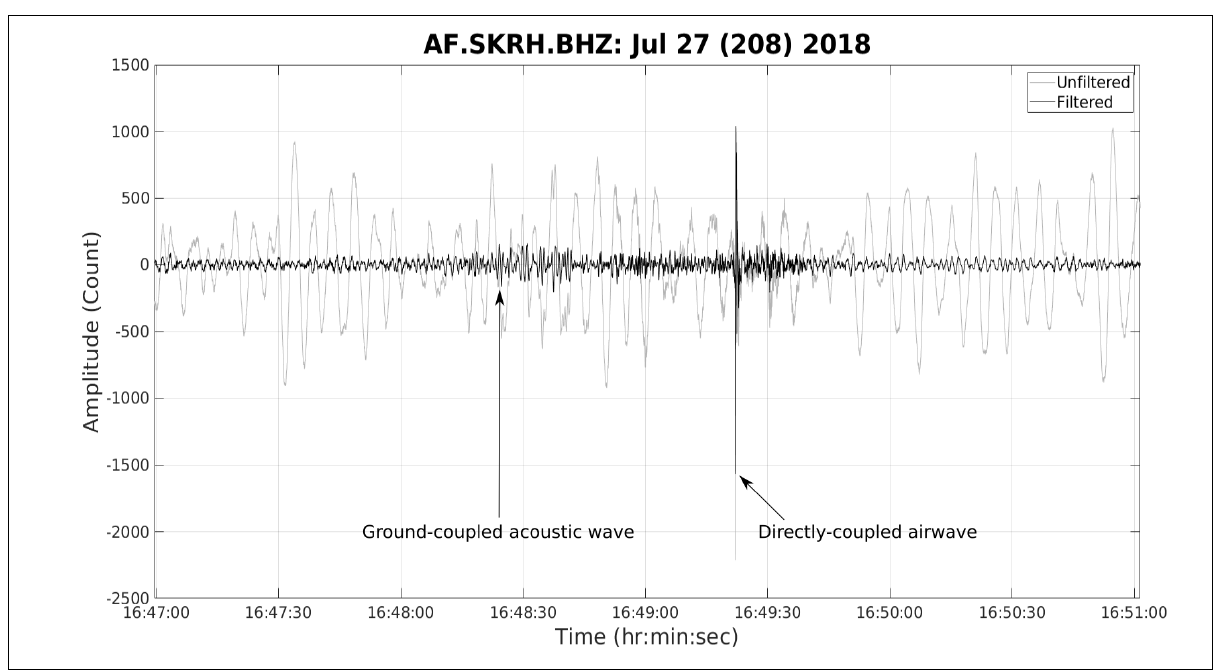
Figure 4: Seismic record from SKRH seismograph station, 77 km north-northwest of Benenitra (22.83°S, 44.75°E; Figure 1), on 27 July 2018, showing the unusual ground motion signature lasting ~100 s, consistent with a bolide source. Grey and black lines are the unfiltered and filtered (0.5–20 Hz) data, respectively. The air-coupled ground wave (see Figure 5) arrived at 16h48:08 UTC in the form of dispersed pulses within the frequency range of ~0.5–5 Hz, consistent with Rayleigh waves. 7,19 The sharp pulse at 16h49:22 UTC displays a W-shaped impulsive onset with downward first motion, consistent with overpressure, and has a frequency range of ~0.1–10 Hz, consistent with a directly coupled airwave.